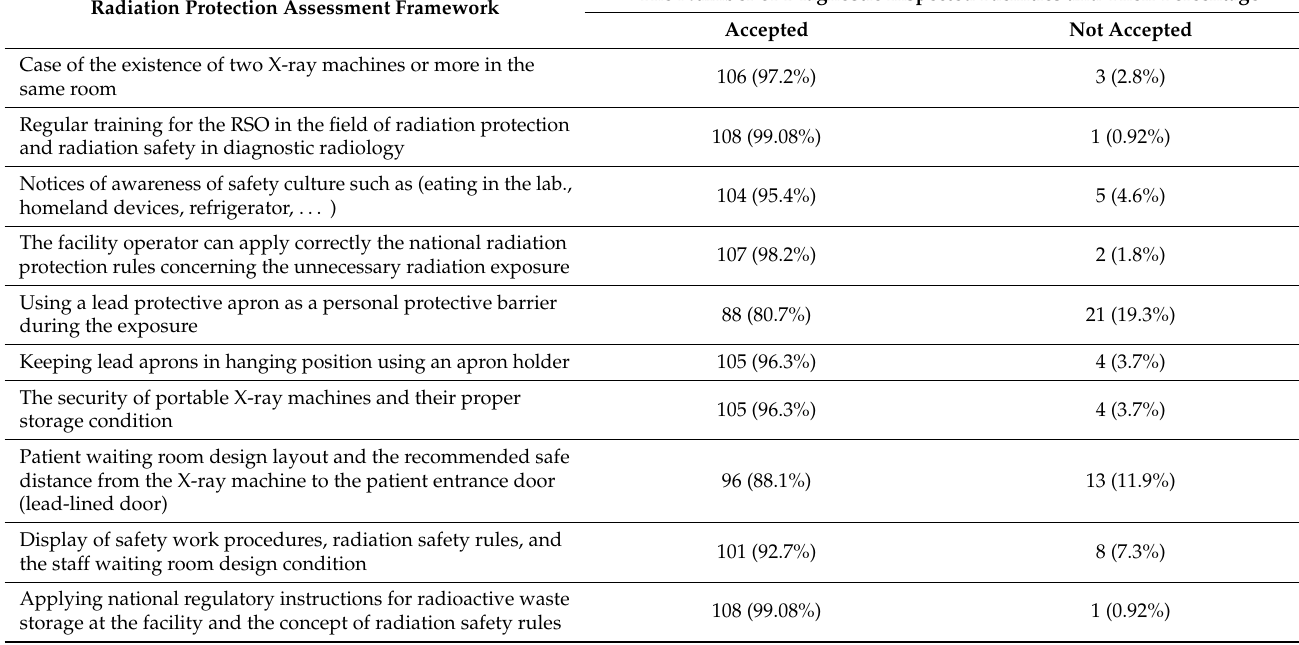
Table 2. Checklist of the observed and registered radiation protection measures during the inspection of the